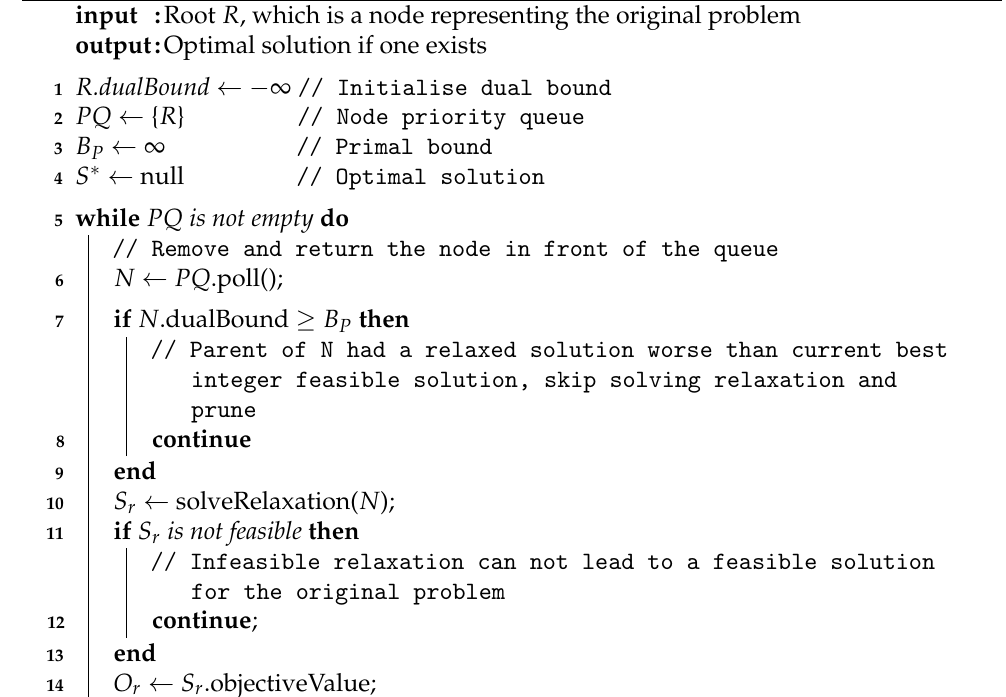
Algorithm 1: Solve a minimisation MIP problem using branch and